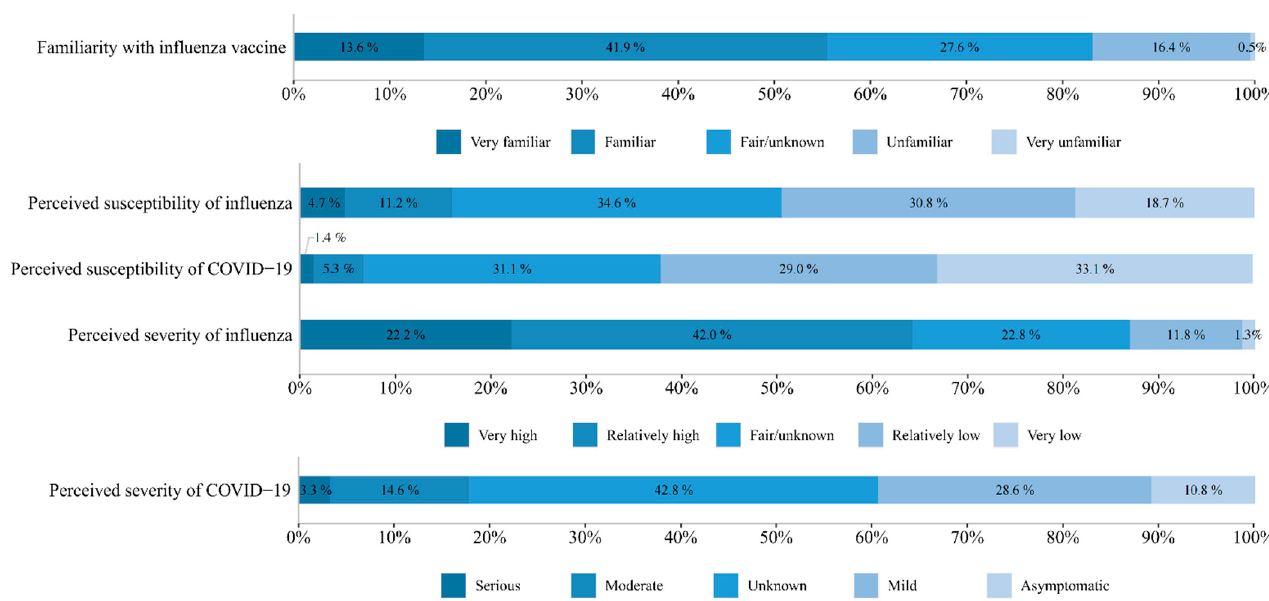
Figure 3. Survey respondents’ perceptions about the influenza vaccine, influenza, and COVID-19 ( n = 3346).